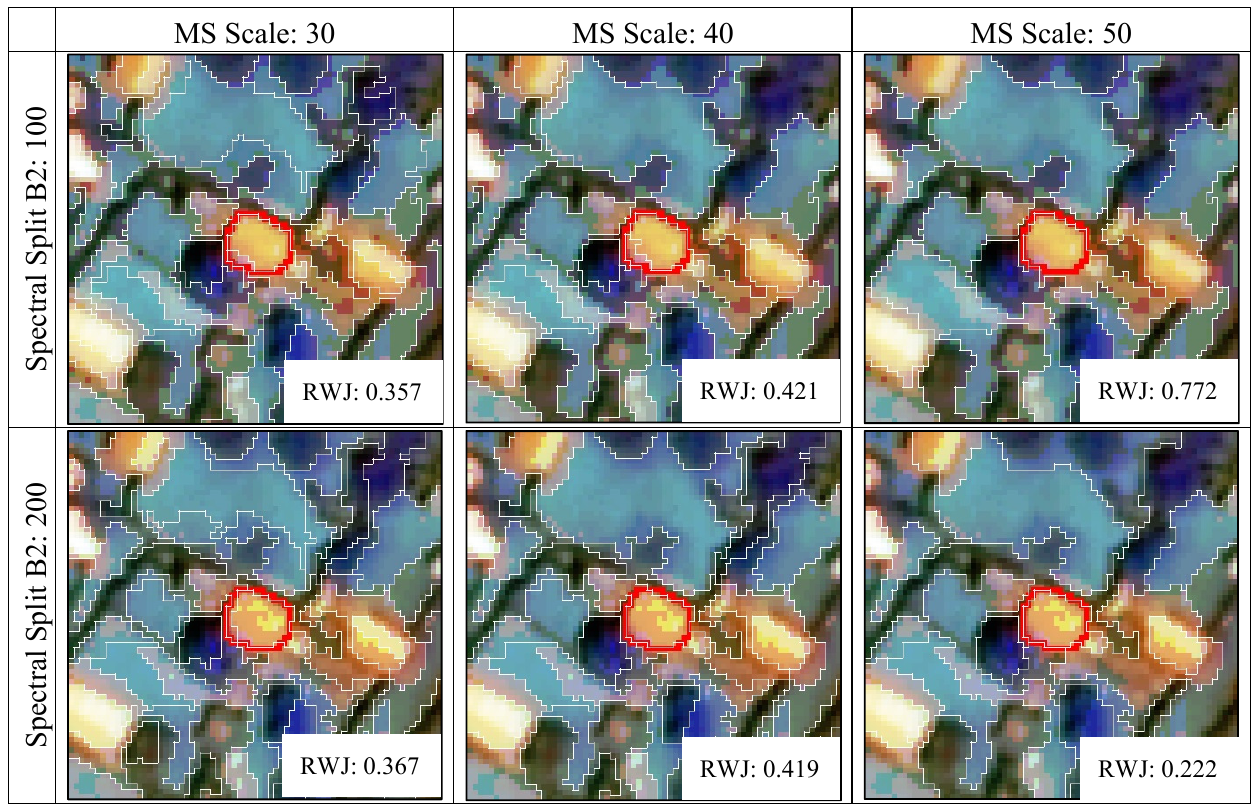
RWJ metric scores. The other parameters of the segmentation algorithm and transformation function were kept constant. Note the differences in metric scores when considering a MS scale parameter of 50. Figure 8. RWJ metric scores on a single object (house) of interest delineated by a bold red line. The Multiresolution Segmentation algorithm and Spectral Split transformation function were